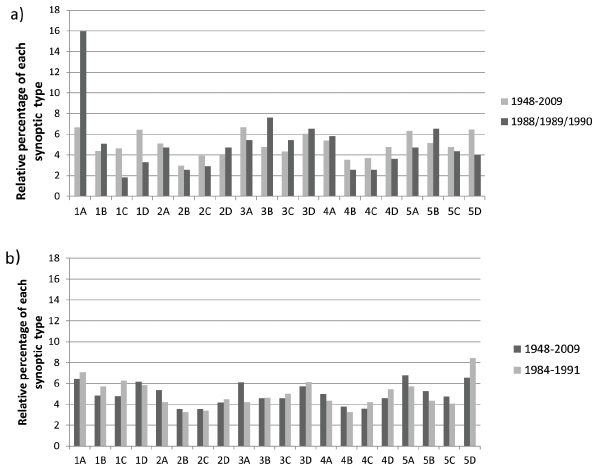
Figure 15. Relative percentage (frequency of occurrence) for